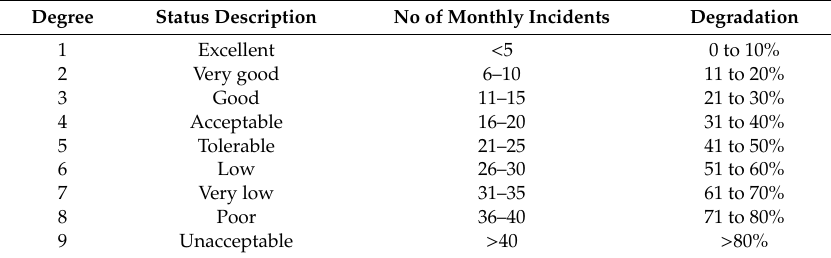
Table 1. Degradation scale of the condition according to the number of